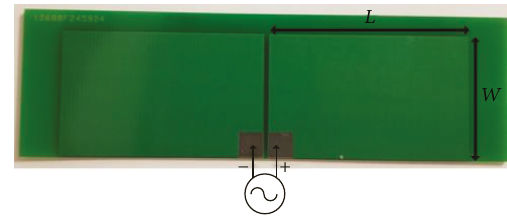
Figure 7: Non-foldable PCB antenna.